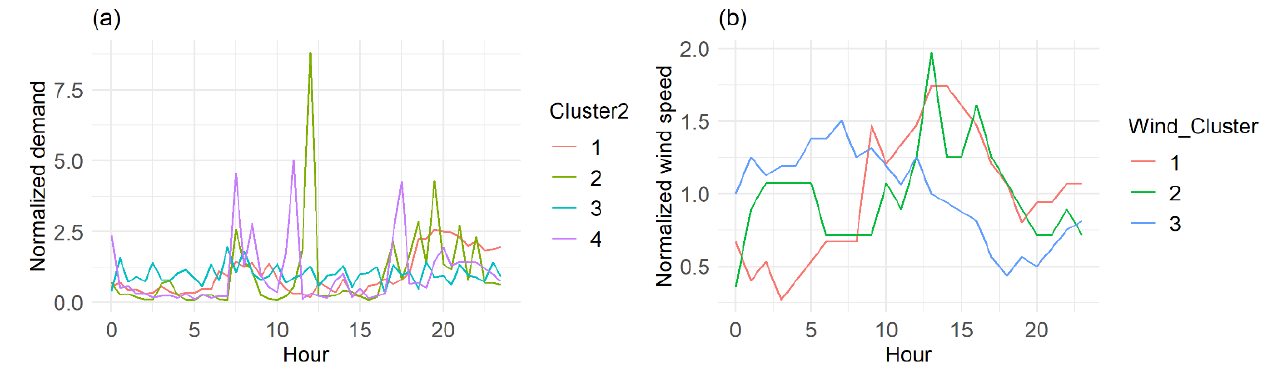
Figure 10. Extraction of load shape and wind medoids representatives. ( a ) Four medoid representatives for load shape. ( b ) Three medoid representatives for wind speed shape.